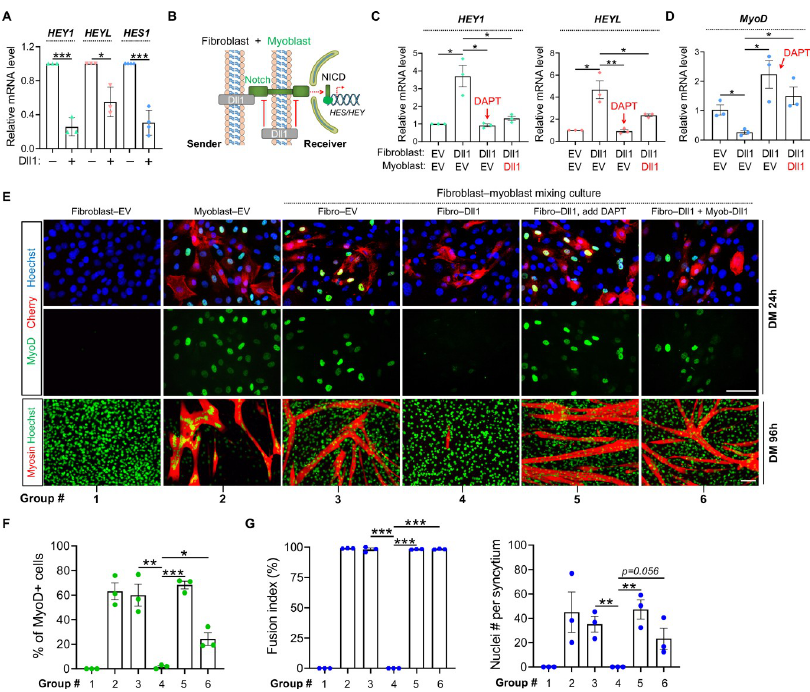
Fig 3. Dll1 cis -inhibits Notch signaling and promotes human myoblast differentiation. ( A ) qPCR results of Notch target genes in human myoblasts in response to Dll1 overexpression. Cells are cultured in growth medium. ( B ) Schematic of Notch signaling in heterologous cell-mixing assays for panels C–G. ( C , D ) Relative mRNA levels of Notch target genes HEY1 / HEYL (C) and MyoD (D) in human myoblasts. Cells were differentiated for 24 hours. n = 3. ( E ) Fluorescence images of mouse fibroblasts (10T1/2) and human myoblasts in separate or mixing-culture conditions. Human myoblasts were labelled by red fluorescence protein Cherry; mouse fibroblasts or human myoblasts were infected by control (EV) or Dll1 expressing retroviruses. Cells were mixed at day-2 post infection followed by myogenic differentiation for 24 hours (top) or 96 hours (bottom). Scale bar, 100 μ m. ( F ) Quantification results of MyoD+ cells as in E (top). n = 3. ( G ) Measurements of fusion index and nucleus number per syncytium of human myotubes as in E (bottom). Cells were differentiated for 96 hours. Treatments in groups 1–6 are same for panels E–G. n = 3. Data are means ± SEM. � P < 0.05, �� P < 0.01, ��� P <